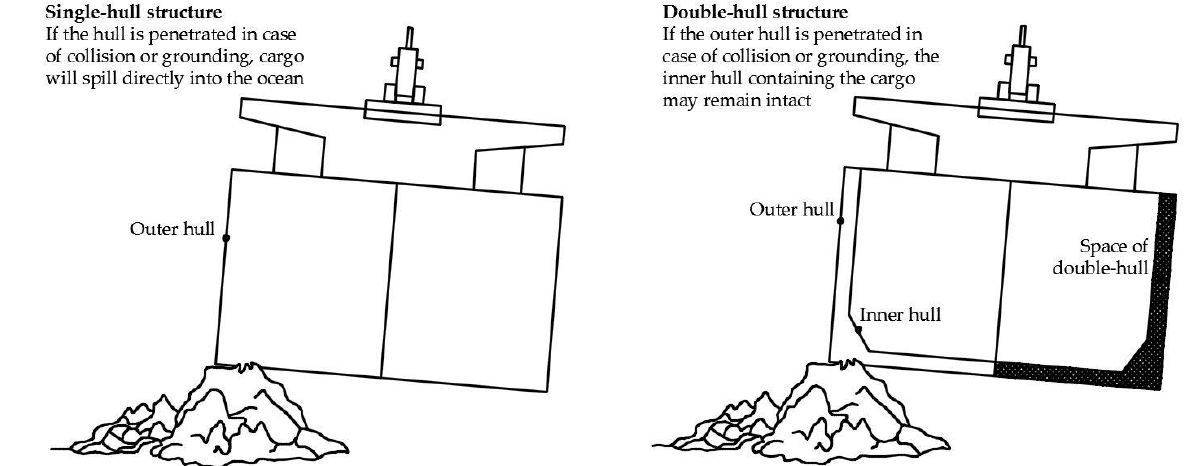
Figure 1: Comparison of the single and double-hull structures against